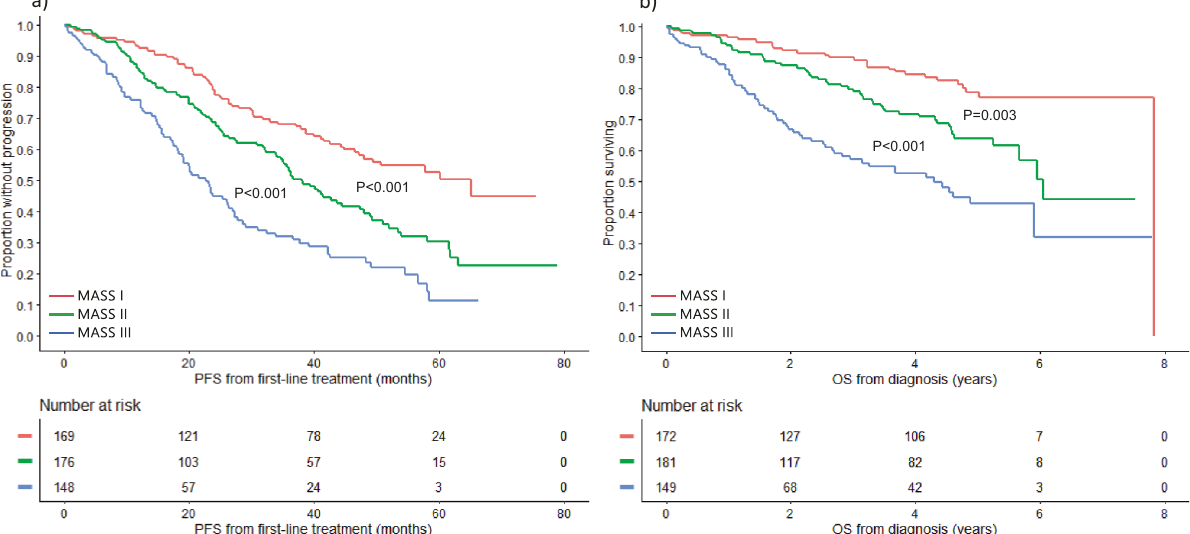
Fig. 6 PFS and OS based on the MASS using the MMRF cohort. a PFS (months) and b OS (years) in MM patients with MASS I (red curve), MASS II (green curve), and MASS III (blue curve) using the MMRF cohort. MASS Mayo Additive Staging System, MM multiple myeloma, OS overall survival, PFS progression-free survival. The P values for each pair of groups are presented between the corresponding